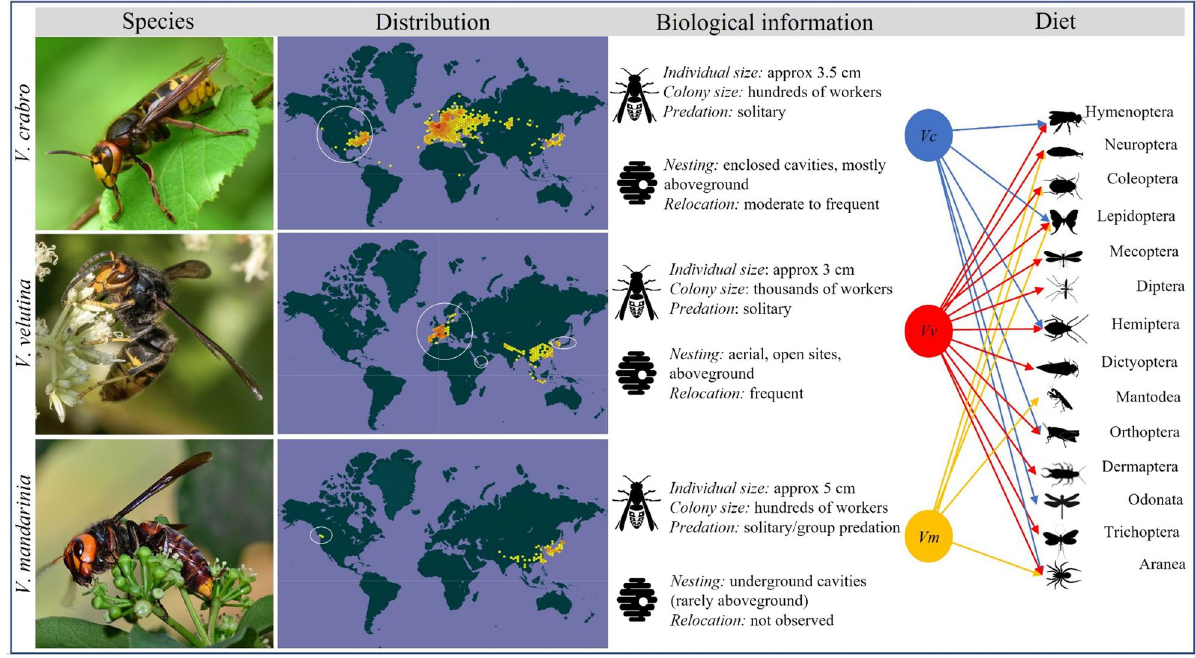
Figure 1. Biology of Vespa hornets. Comparing the key life-history traits of the three Vespa species analyzed in this study. Species column: Female adult morphology for Vespa crabro , Vespa velutina and Vespa mandarinia (photos taken from www. inatu ralist. org, respectively from the following users: rainyang, Mиxaил Maлышeв, Kinmatsu Lin, all photos have CCBY-NC license). Distribution column: Known geographical distribution of species (from https:// www. gbif. org/) 40–42 ; the redder patches indicate higher occurrence records; their invasive distributions are circled. Biological information column: Descriptions of individual and nest traits and behaviours 28,37,39,43 . Diet column: All three Vespa species (left) prey on a diverse set of arthropod orders (right) 8,44,45